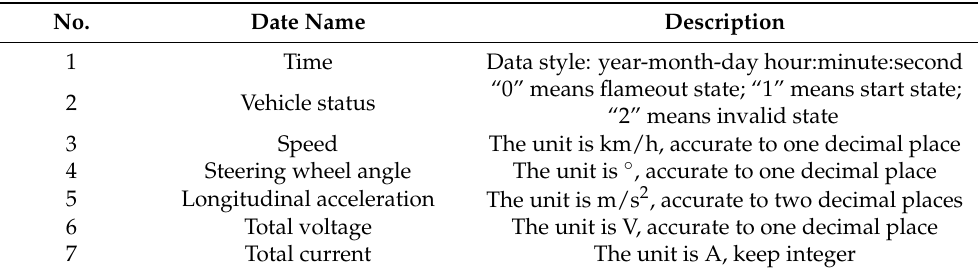
Table 1. The required data fields for driving behaviors.